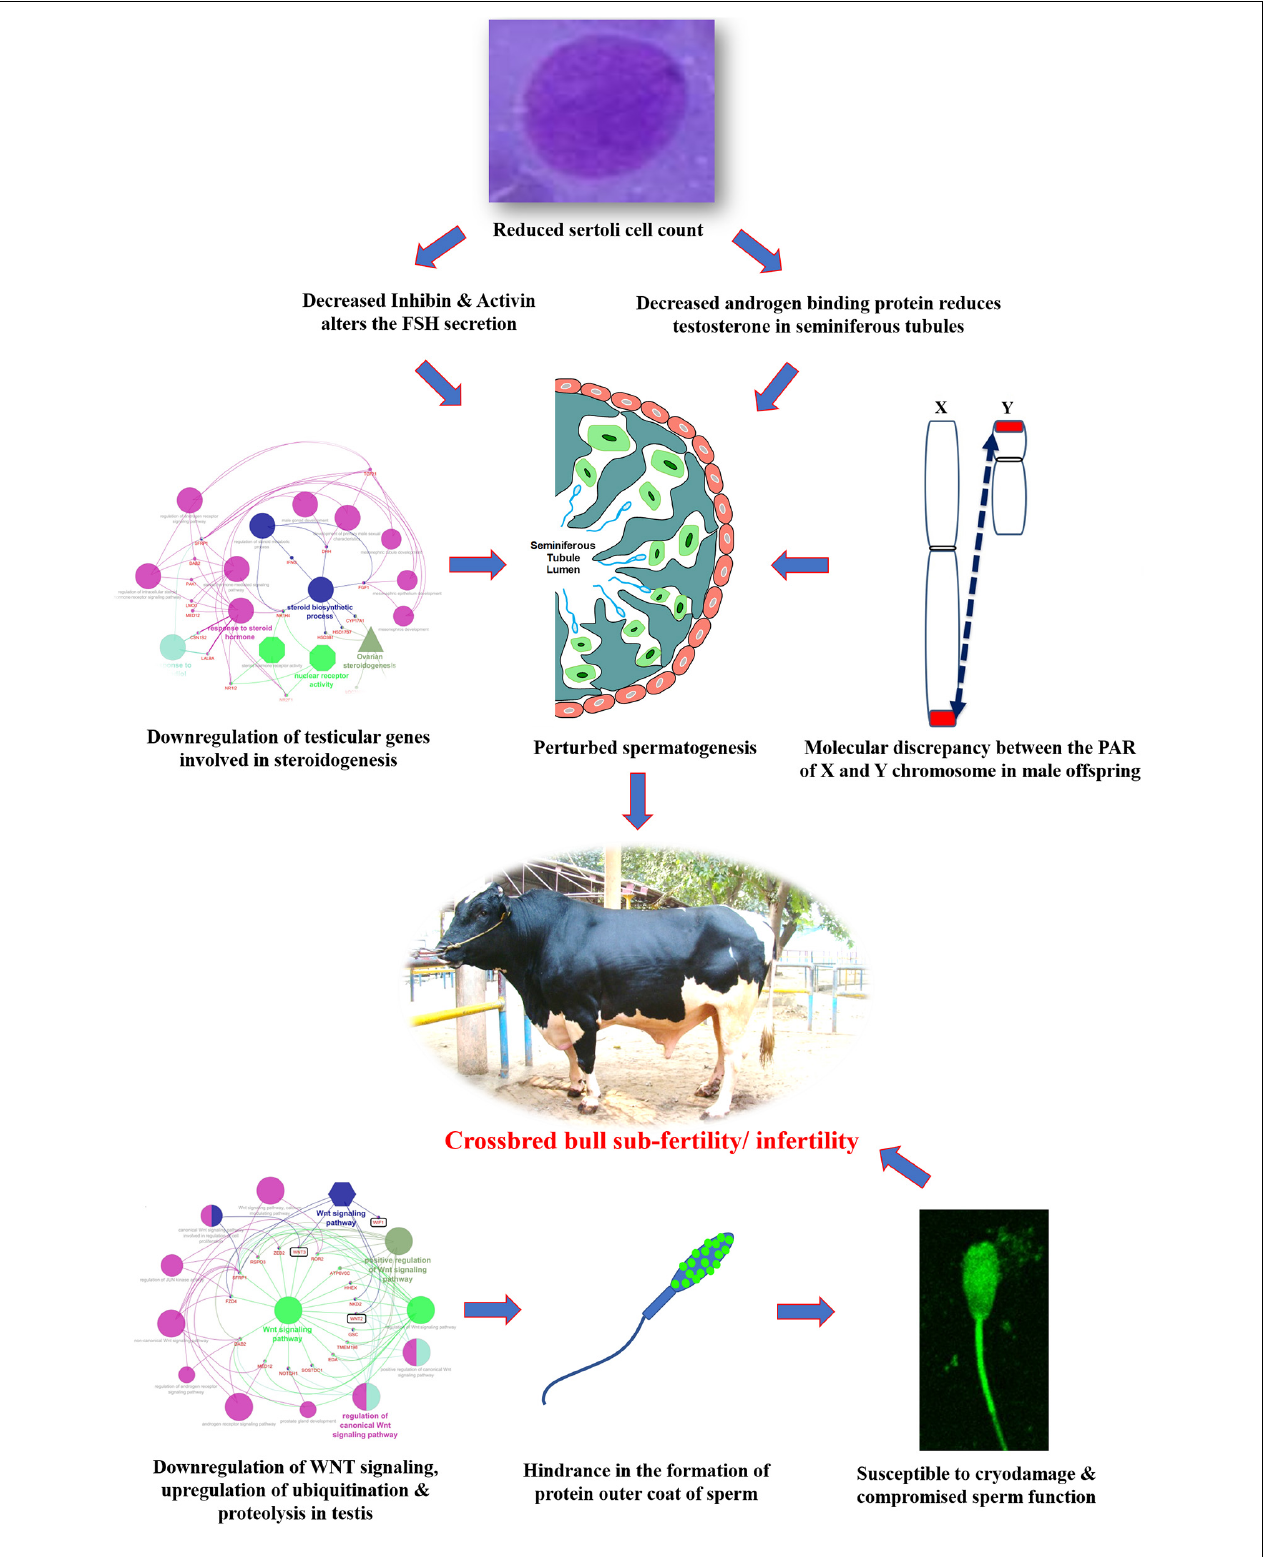
FIGURE 8 | Hypothetical model indicating the possible etiologies of crossbred bull subfertility/infertility.